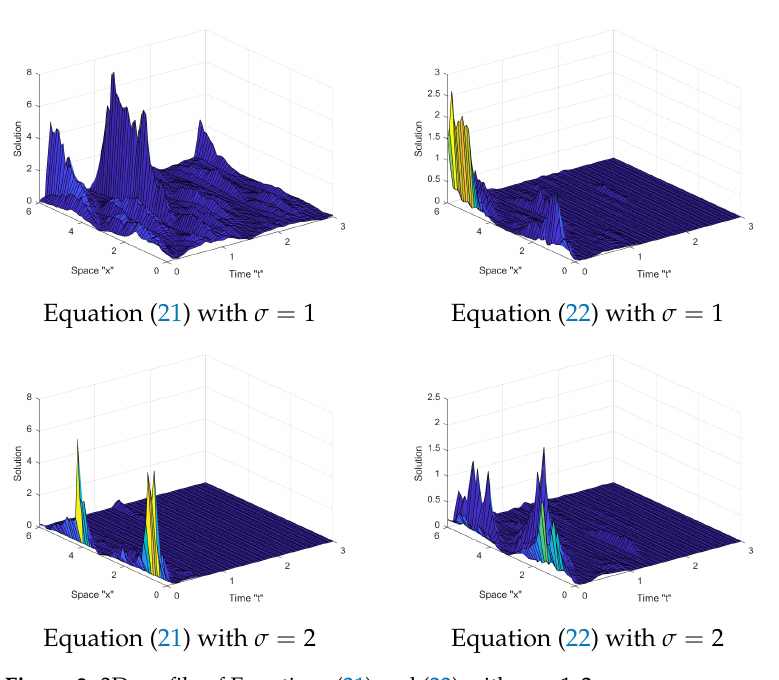
Figure 2. 3D profile of Equations (21) and (22) with σ =